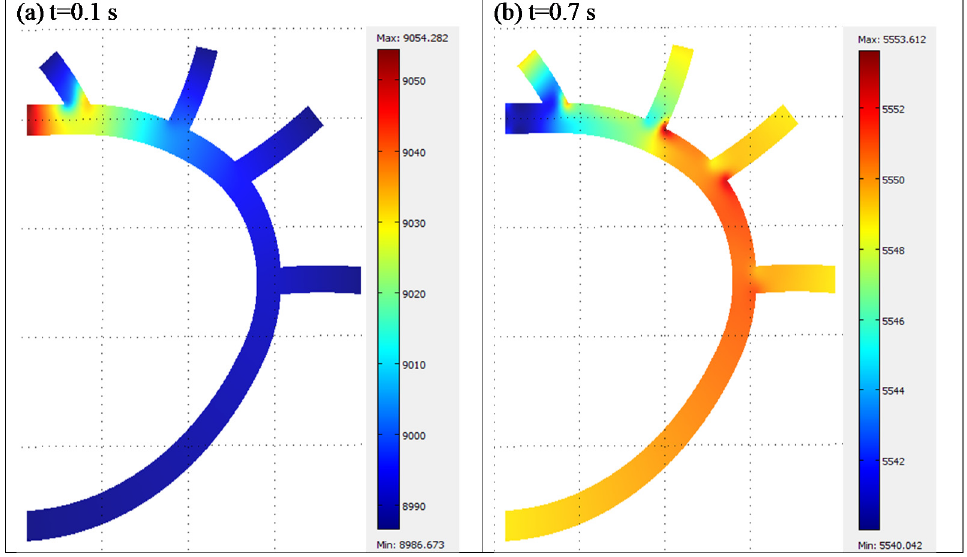
Figure 6. Pressure distribution inside the vessel at different times; ( a ) t=0.1 s and ( b ) t=0.7 s.